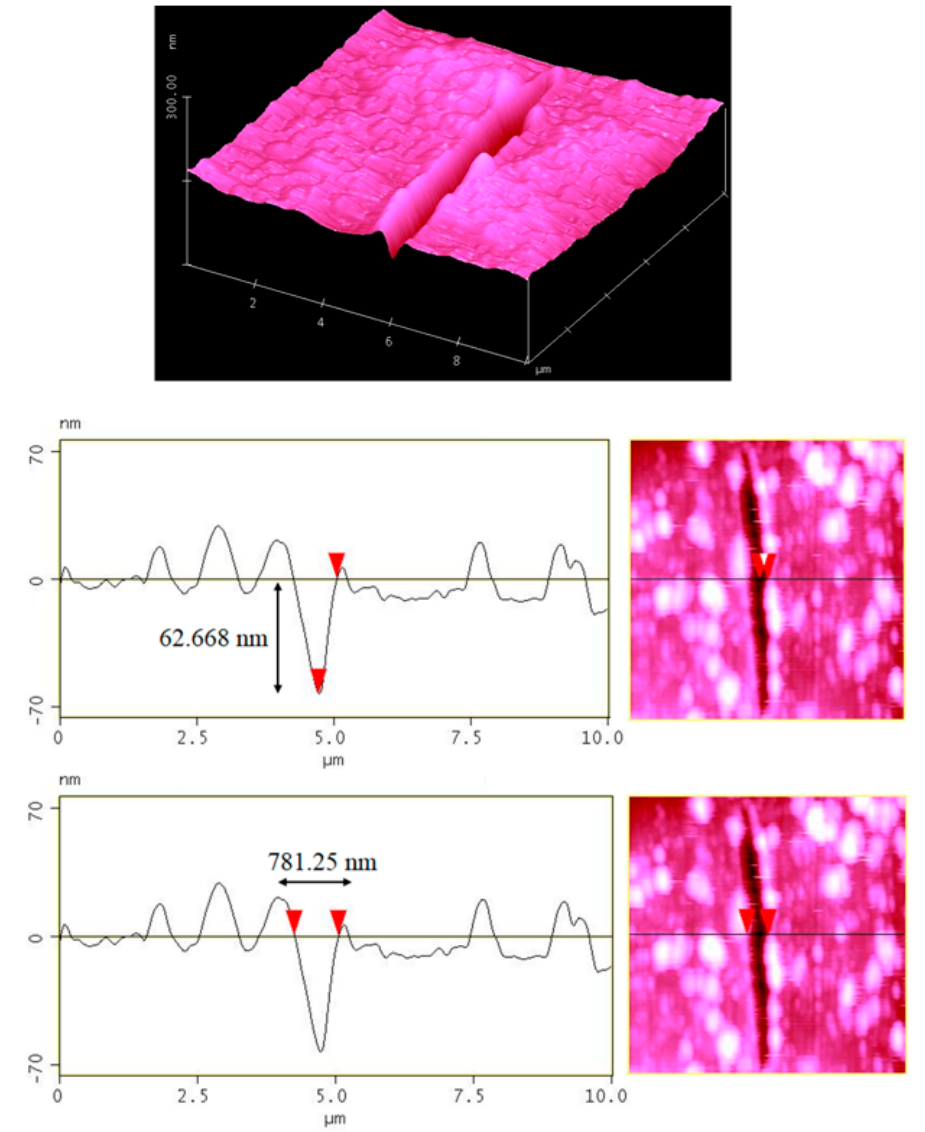
Figure 11. AFM image of a scratch from (Fe,Ti) 3 Al and its associated cross